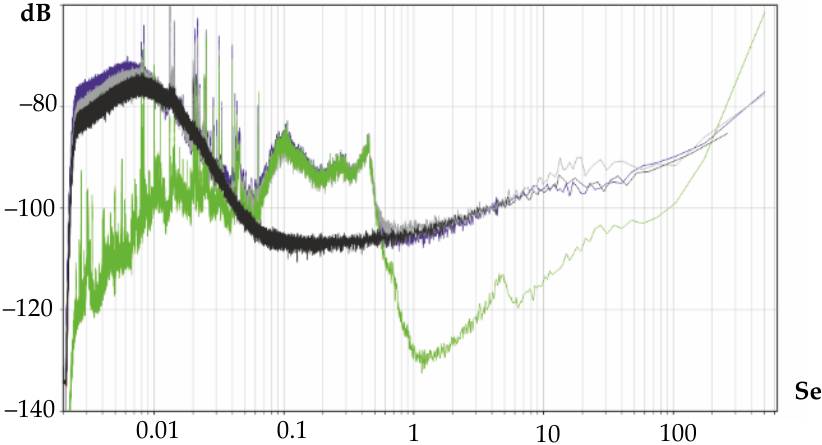
Figure 10. Spectral signal density of electrochemical seismic sensors filled with electrolyte sensor samples, where #1 is the blue curve and #3 is the gray curve. (dB relativ to 1 m/s 2 /√Hz) .